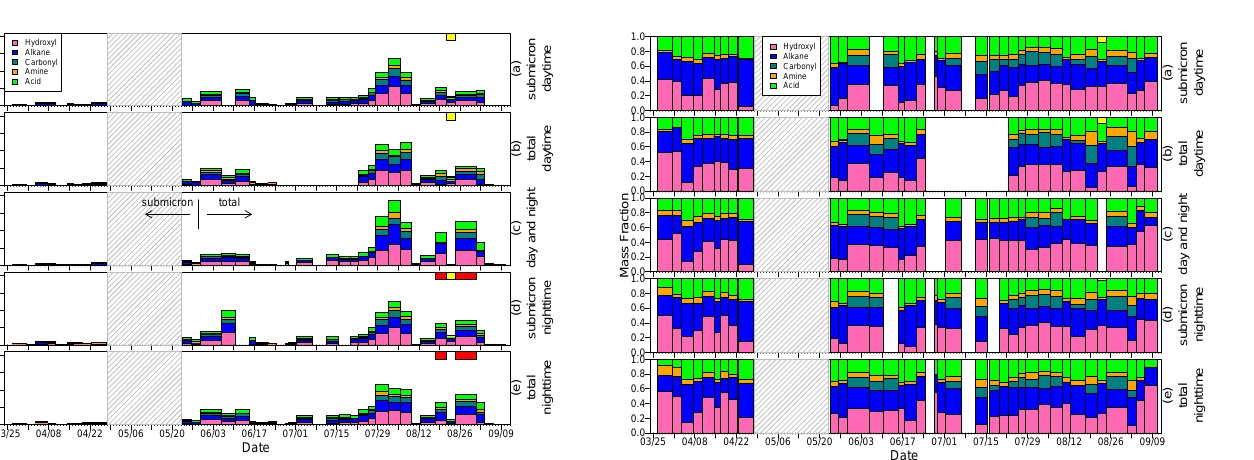
Fig. 2. Time series of OFG fraction as stacked bars with colors as in Fig. 1 (organic hydroxyl (pink), alkane (blue), ketone (teal), pri- mary amine (orange), acid (green), organosulphate (yellow)) in (a) day submicron, (b) day total, (c) day and night (submicron before 29 May 2009, and total post that date), (d) night submicron and, (e) night total aerosol for OM above detection limit